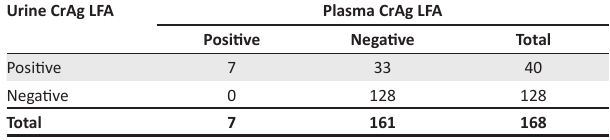
TABLE 2: Sensitivity and specificity of urine cryptococcal antigen lateral flow assay compared with plasma cryptococcal antigen lateral flow assay for patients with a CD4 count < 200 cells/mm 3 , Eswatini, August 2014 to March